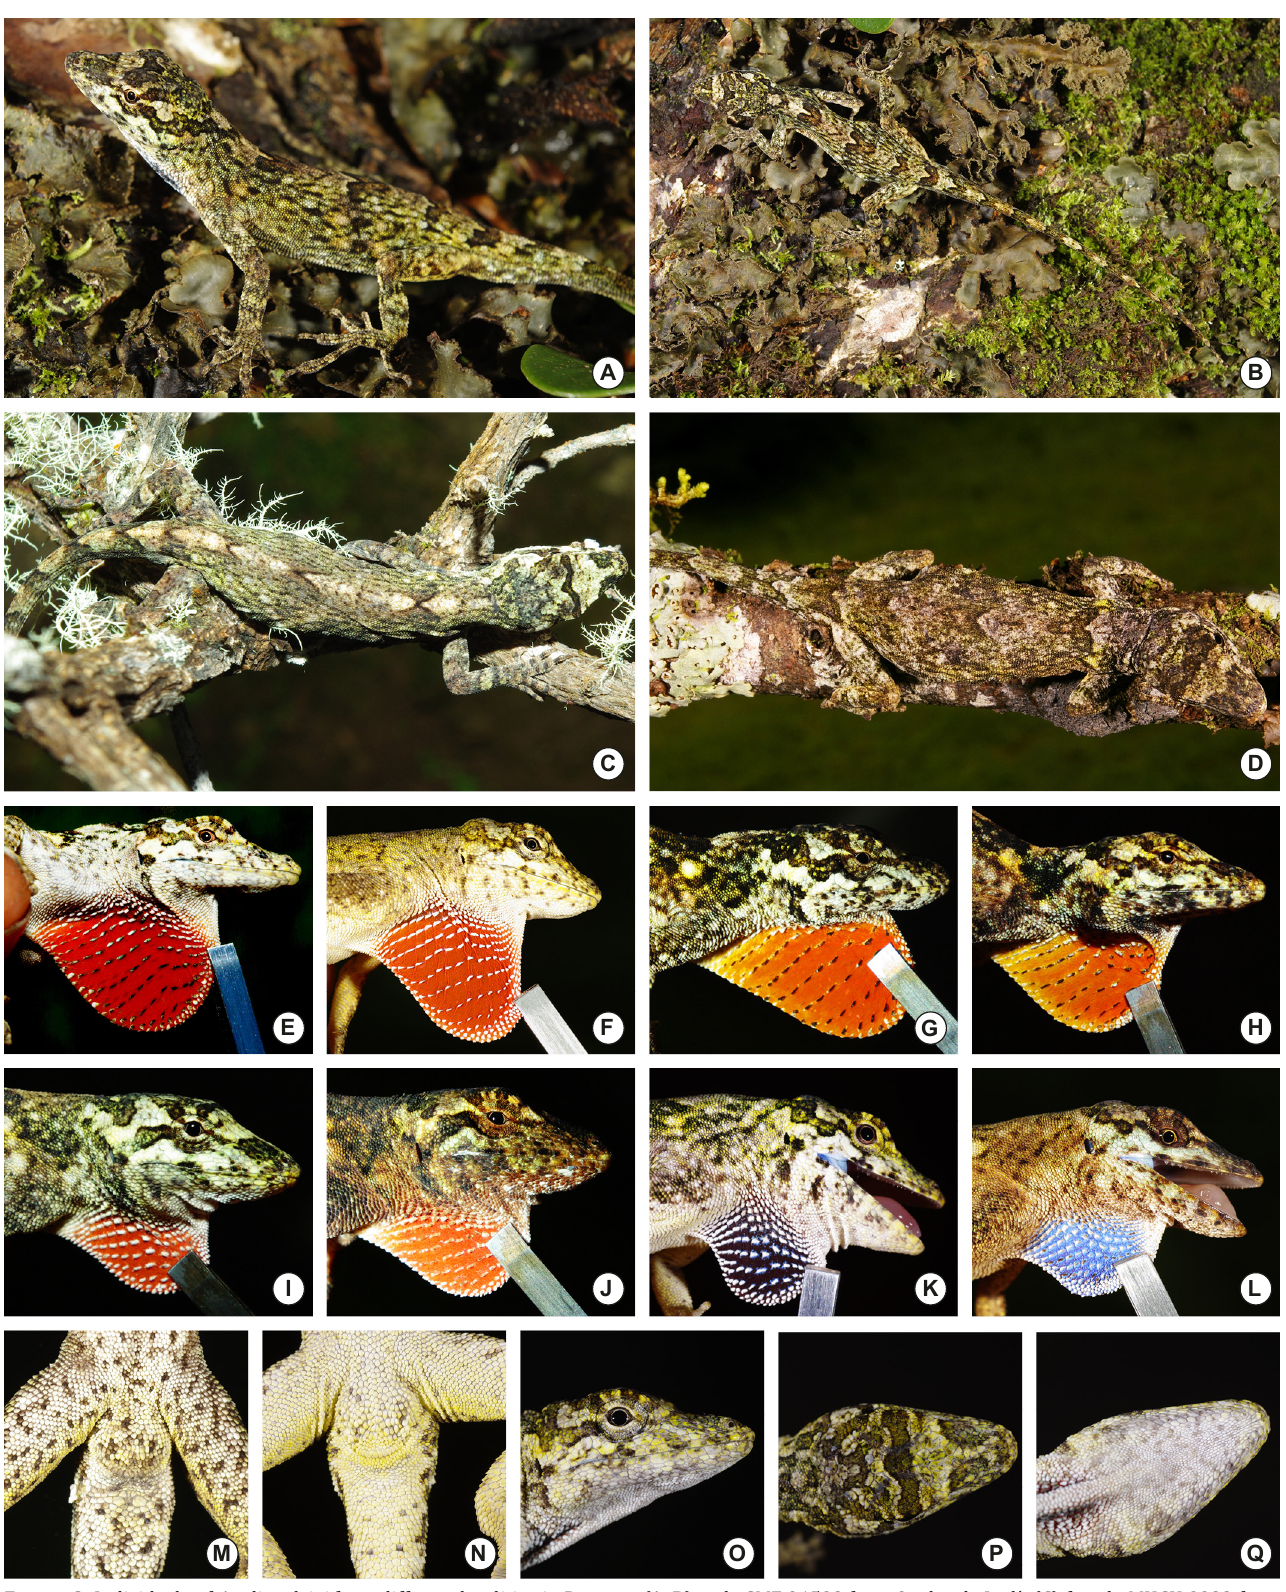
N O P Anolis salvini Figure 2. Individuals of from different localities in Panama: (A–B) male SMF 91528 from Quebrada Juglí; (C) female MHCH 2288 from Alto Jaramillo; (D) female SMF 89527 from Jurutungo; (E–H) male dewlaps: (E) SMF 85451 from Jurutungo; (F) SMF 91526 from Quebrada Juglí; (G) SMF 90168 from Alto Jaramillo; (H) SMF 90167 from Alto Jaramillo; (I–L) female dewlaps: (I) MHCH 2288; (J) MHCH 2289 from Alto Jaramillo; (K) MHCH 2291 from Jurutungo; (L) SMF 91523 from Ratón; (M–N) cloacal region: (M) male MHCH 2293 from Quebrada Juglí; (N) female MHCH 2291 from Jurutungo; (O–Q) head: SMF 89758 from Jurutungo; (O) lateral, (P) dorsal, (Q) ventral view.